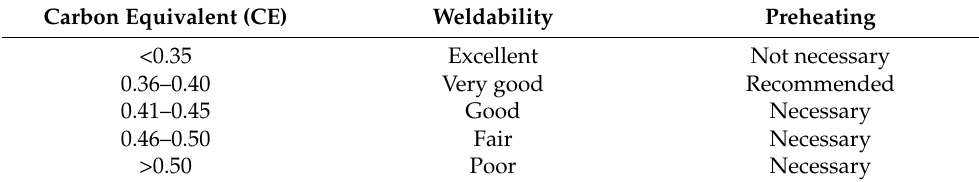
Table 4. Weldability classes in terms of the CE